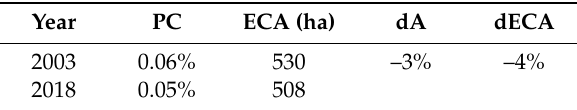
Table 5. Values of the probability of connectivity (PC) index, equivalent connected area (ECA) and percentage changes in total habitat area (dA) and ECA (dECA) for the 2003 and 2018 crested tit habitat networks.